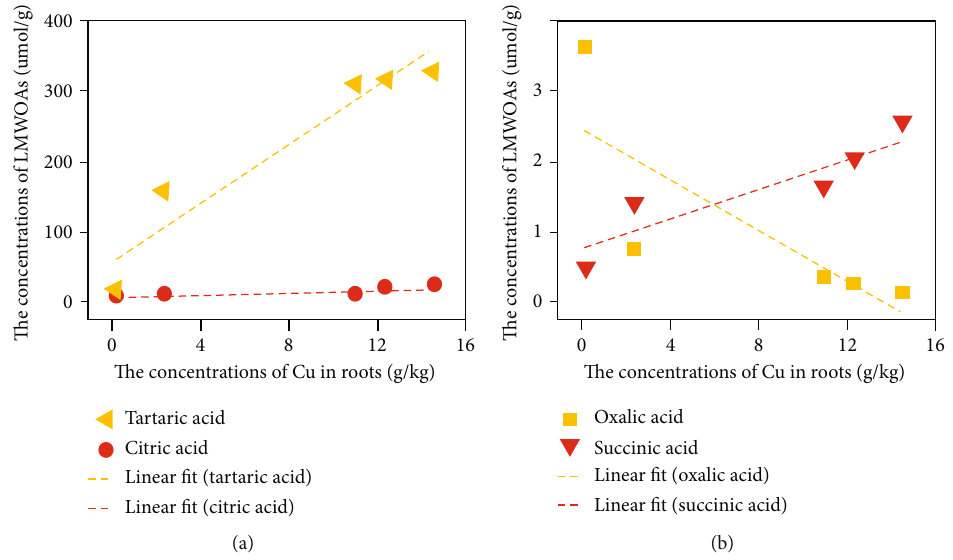
Figure 4: Linear correlation between organic acid content in willow root exudates and Cu content in willow